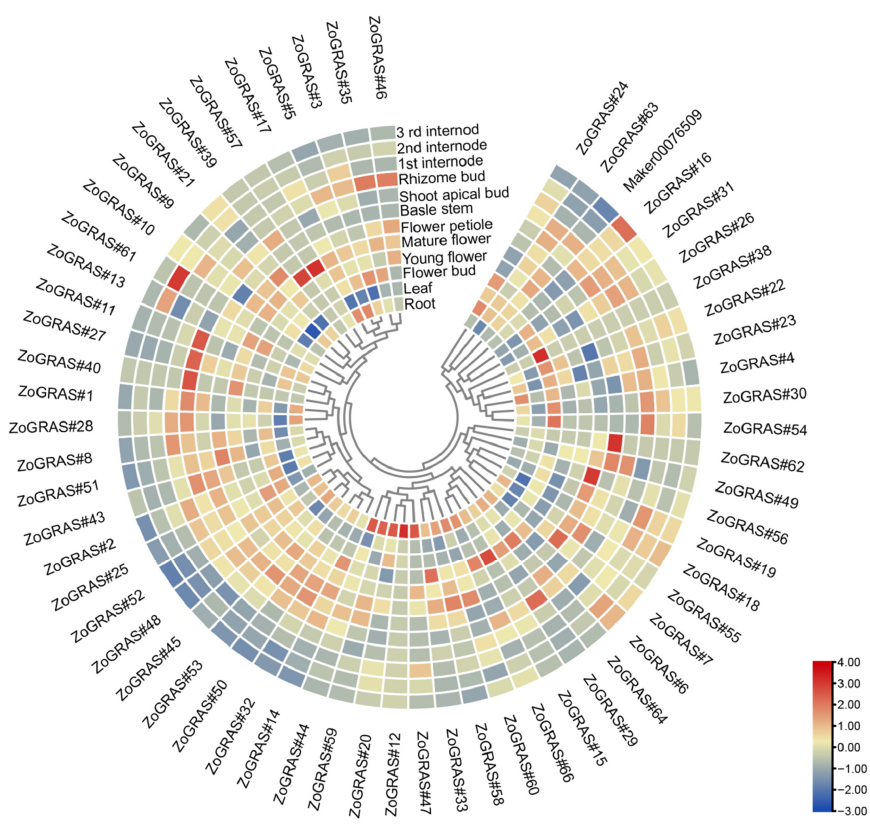
Figure 11. GRAS gene expression profile of ginger. Hierarchical clustering of GRAS gene expression profiles of ginger in 12 samples, including different tissues and developmental stages.